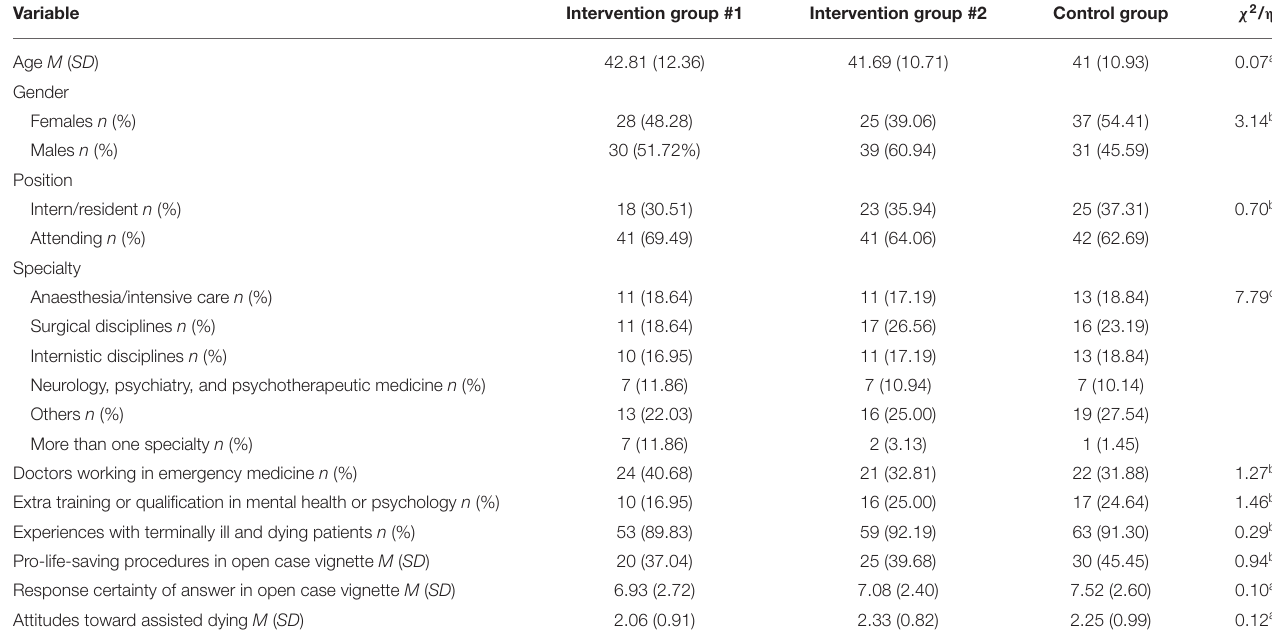
TABLE 1 | Descriptive statistics for intervention group #1: reading educative material disfavouring life-saving procedures ( n = 59), intervention group #2: reading educative material favouring life-saving procedures ( n = 64), and control group: no educative material ( n = 69).